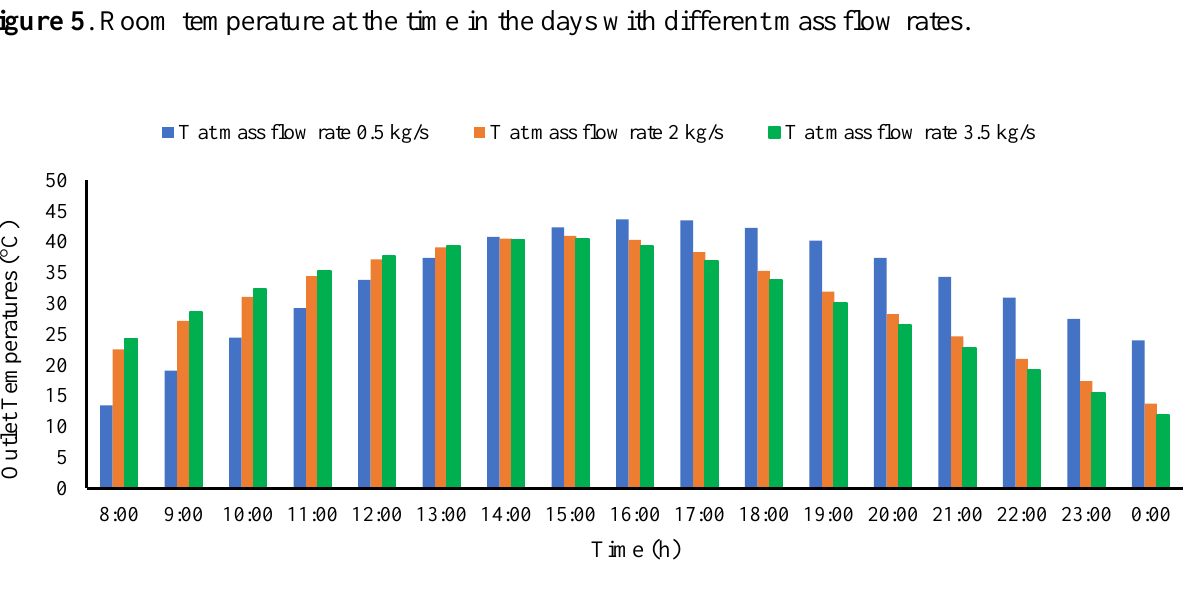
Figure 6. The outlet temperature between the roof and gypsum